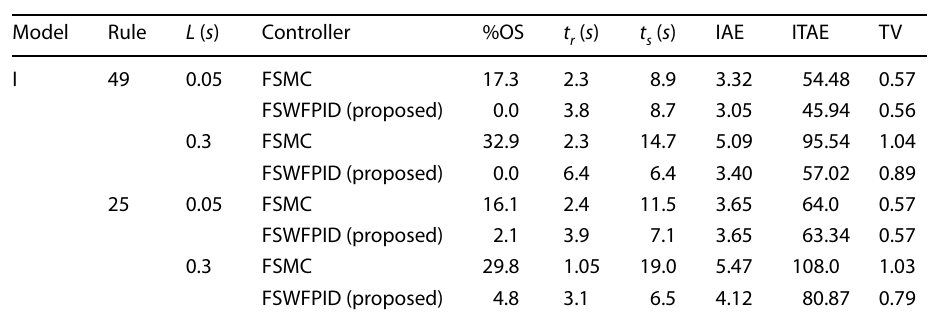
Table 6 Performance analysis for Model I